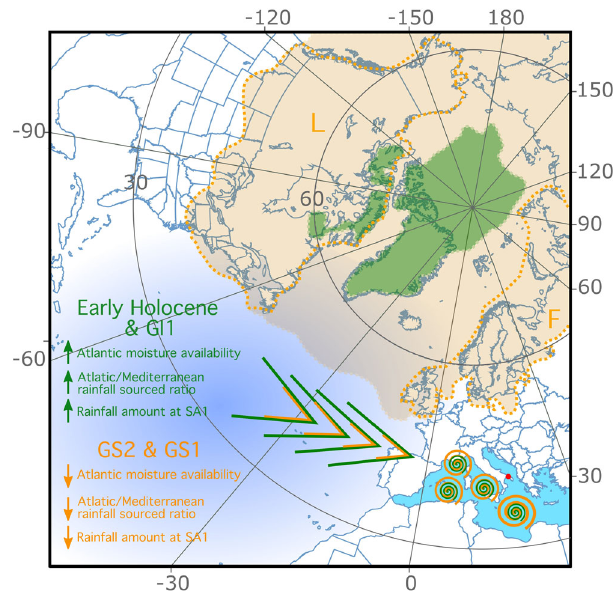
Fig. 4 Controls on central Mediterranean rainfall during T-I. Extension of Holocene and GI1 northern ice (green shading) compared to GS2 and GS1 (orange shading). The extent of the Greenland, Laurentide (L) and Fennoscandian (F) ice sheets is shown by dotted lines. The two main moisture sources for the study area (red dot) are marked by open triangles and spirals during the Early Holocene and GI1 (green) and GS1 and GS2 (orange), with their size proportional to their importance. During GS1 and GS2, northern ice sheets expanded, global temperatures decreased and the AMOC weakened. This reduced the westerly moisture advection into the central Mediterranean, where rainfall was mainly derived from Mediterranean cyclogenesis (orange spirals). In the central Mediterranean (study area), the rainfall amount dropped accordingly. During GI1 and the Early Holocene, the northern ice sheets retreated, regional temperatures increased and the AMOC became stronger. The higher availability of Atlantic moisture and increased advection across the Mediterranean Sea led to higher rainfall in the central part of the basin, while Mediterranean cyclogenesis played only a minor role in the study site, similar to modern conditions (see Supplementary Fig.